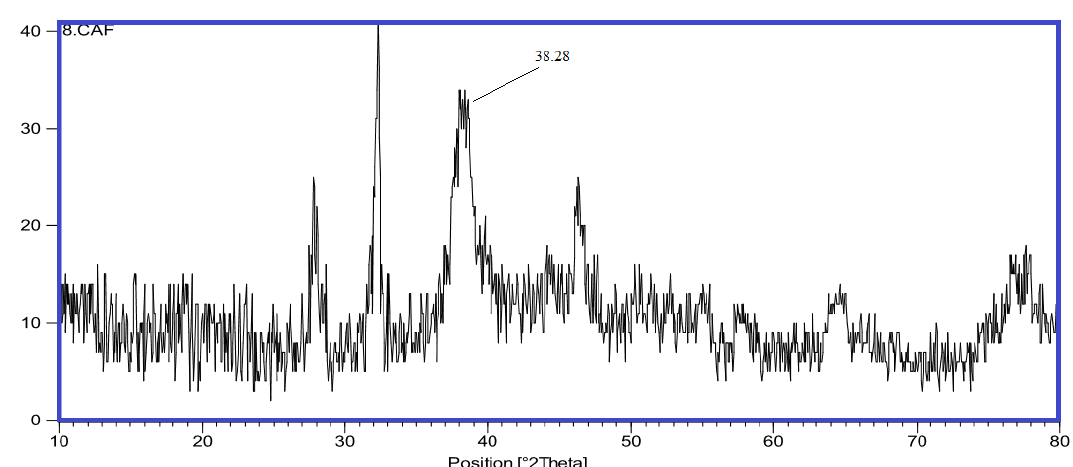
Fig. 4. XRD diagram of